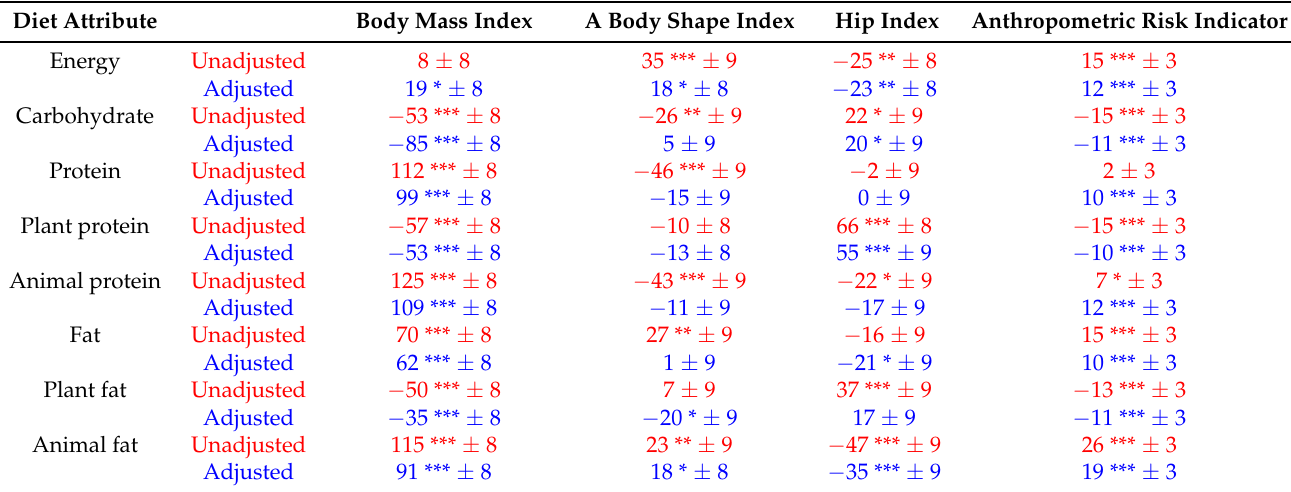
Table 1. Diet associations with